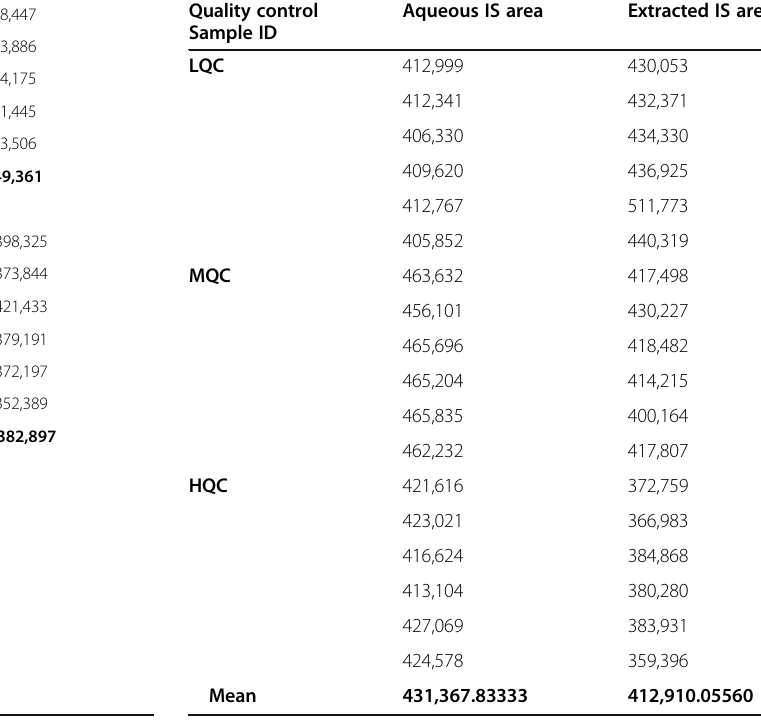
Table 12 Recovery of internal standard Quality control Sample